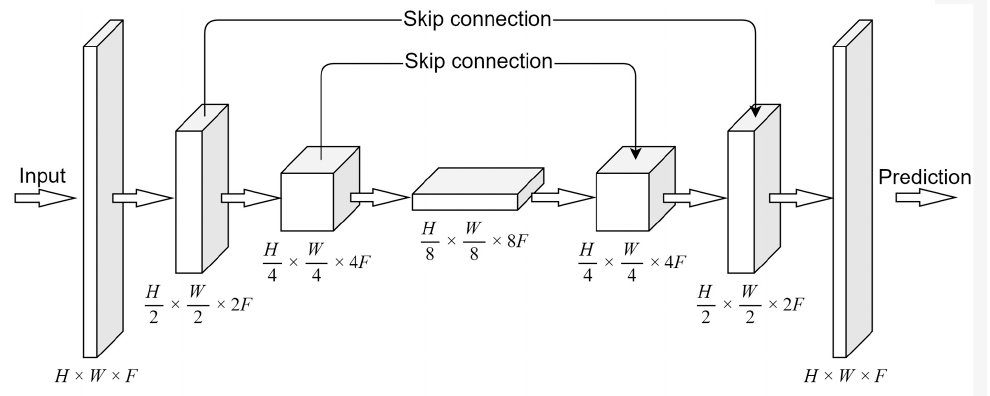
Figure 2. Simple representation of an autoencoder architecture with the addition of skip connections. H, W and F represent the height, width, and number of filtered feature maps, respectively. In this study, H and W are both 200 pixels, while F depends on the specific model